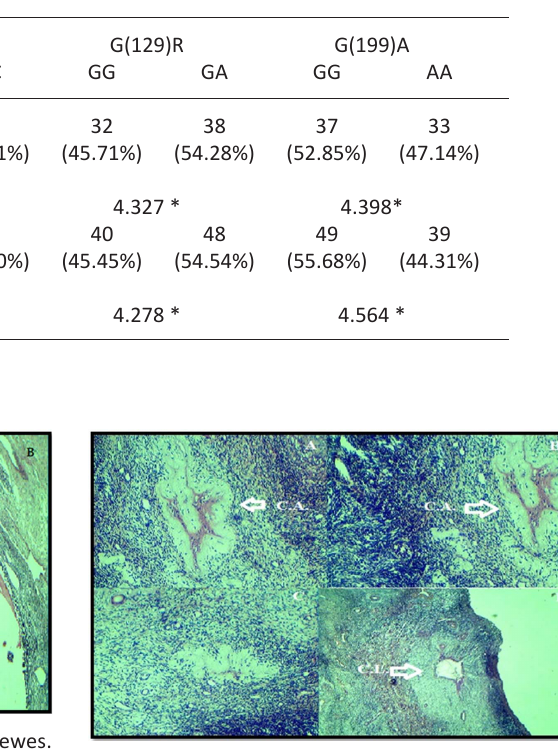
Fig.4. Histological analysis of normal fertile ewesovaries. (A) Normal follicular development with presence many corpus albicans. (B) Degeneration corpus